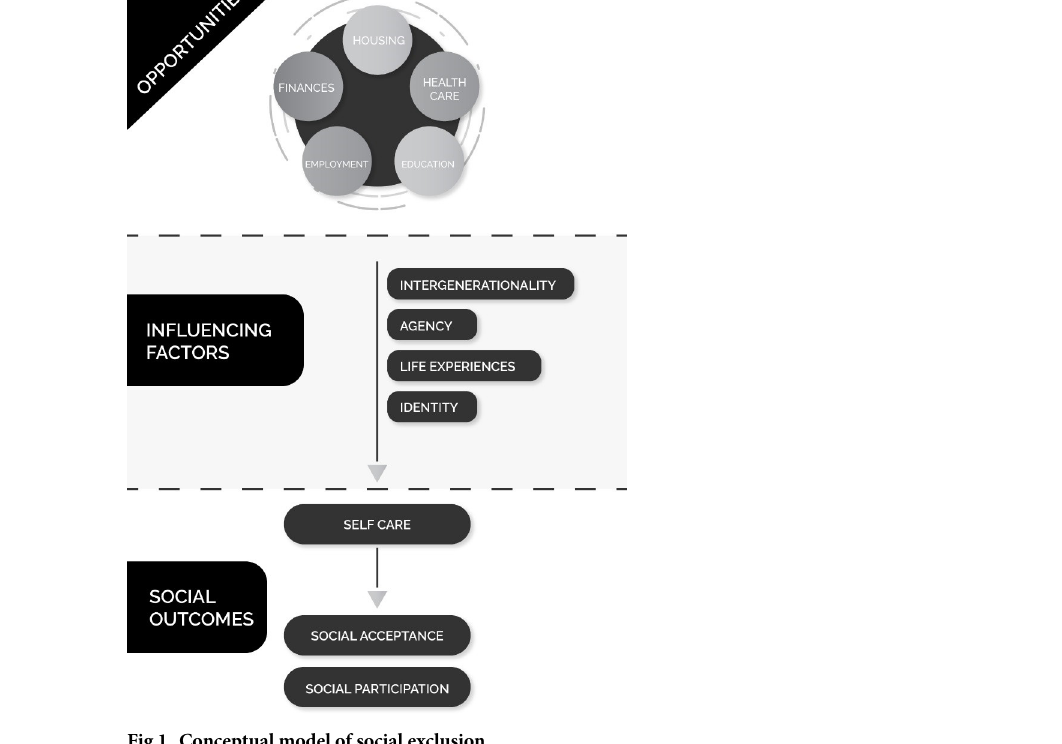
Fig 1. Conceptual model of social